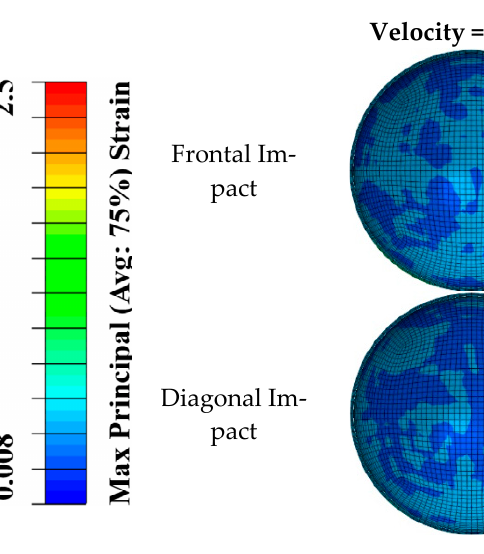
Figure 4. The distribution of maximum principal strain in the posterior retina in frontal and diagonal impact scenarios at three different velocities.